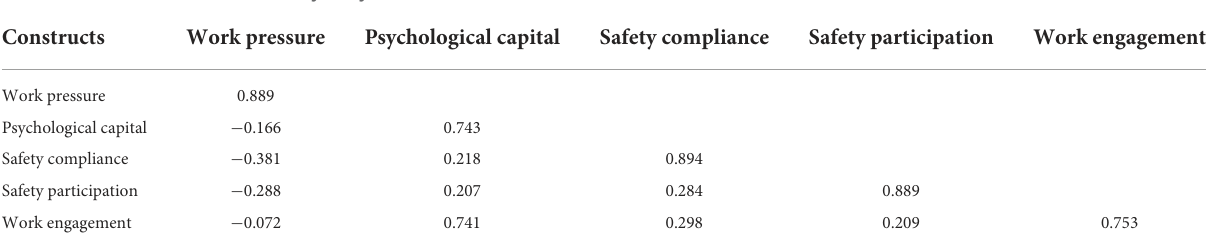
TABLE 3 Result of discriminant validity